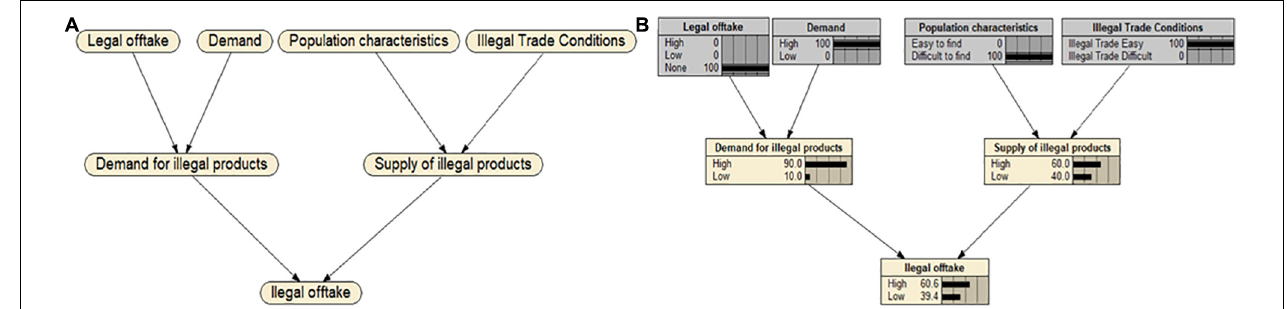
FIGURE 2 | Example of a small BBN which could form part of the BBN for the illegal wildlife trade. (A) The relationship between different nodes. (B) The states of each node and the probability of being in each state. The gray boxes show findings—where the states of the nodes are set. Here, there is a 60.6% chance that Illegal offtake is high when there is no Legal Offtake , Demand is High , Population is Difficult to find, and Illegal trade conditions are Easy . These are illustrative probabilities only. The Basic Model section provides further reasoning for this BBN.